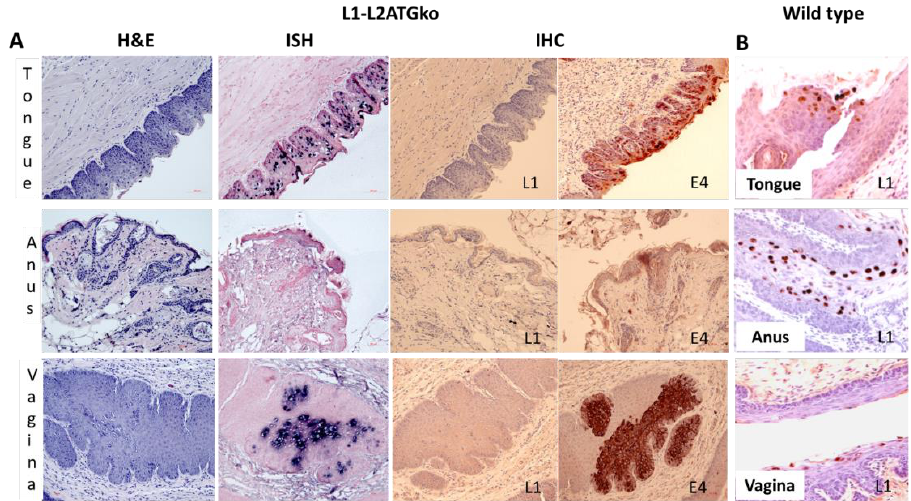
Figure 6. Three mucosal sites (vagina, tongue, and anus) infected with the L1-L2ATGko mutant demonstrated strong viral DNA and E4 expression but absence of L1. Viral DNA positivity was detected in the vaginal tracts and oral cavities of the infected animals of the L1-L2ATGko mutant ( A , ISH, 20×, and arrows). L1 was undetectable in these tissues by immunohistochemistry (IHC) with MPV.B9 ( A , 10×). However, all infected tissues showed intracytoplasmic E4 expression ranging from multifocal and light (anus) to more extensive and strongly positive expression (tongue and anus) ( A ). L1 expression is scattered but marked in wild-type MmuPV1 infected tissues by MPV.B9 in the nuclei of infected cells ( B , 20×).